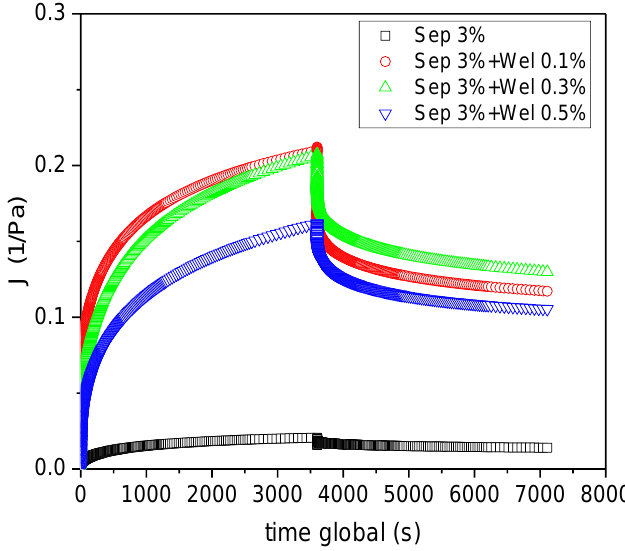
Figure 3. Creep-recovery results for sepiolite gels 3%wt. and sepiolite-welan gels at 20 °C. Standard deviation of the mean (three replicates) for compliance was less than < 10 %.